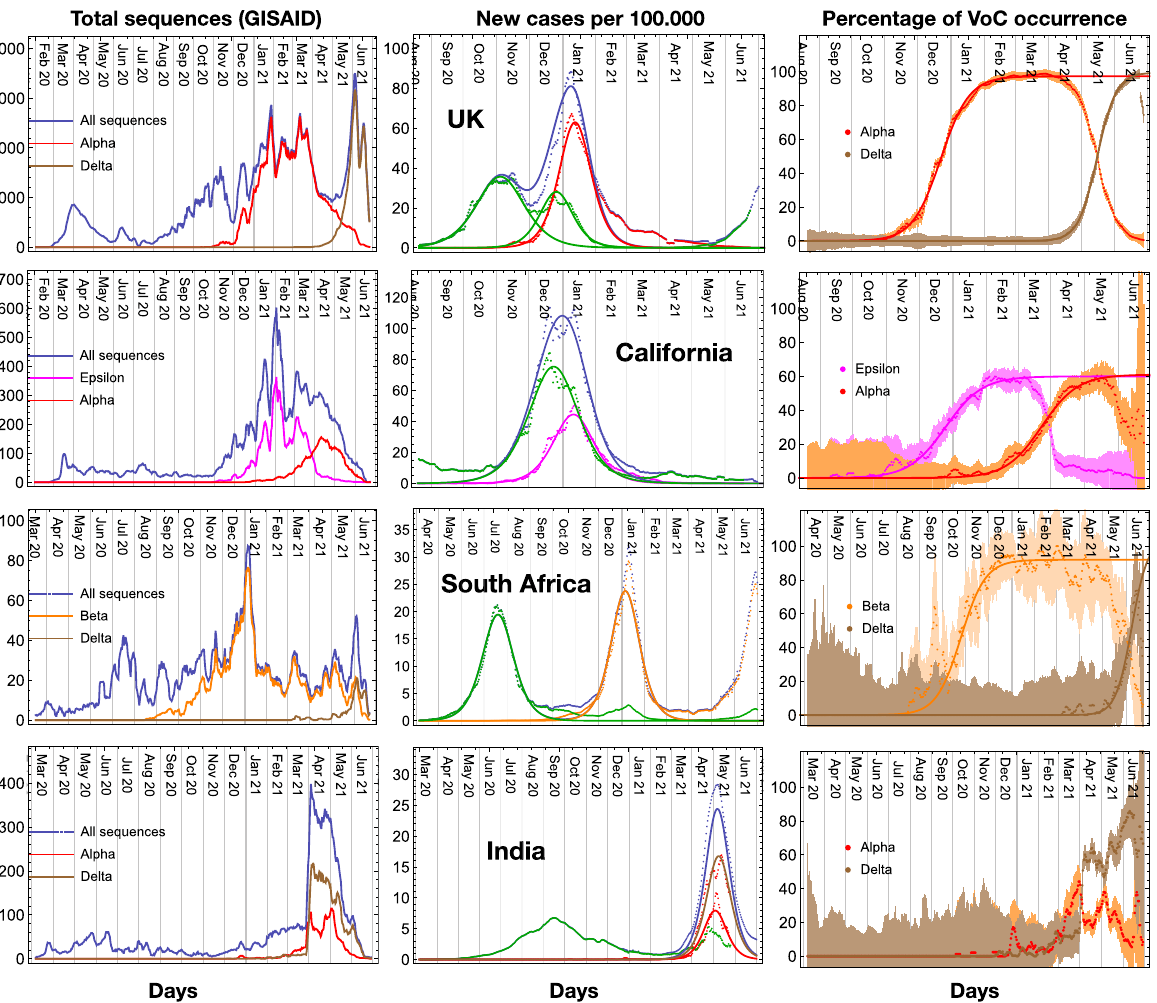
Figure 6. MeRG model for epidemiological data of variants. Results of the MeRG fitting of the number of infected associated to each relevant variant. Each row corresponds to a geographical region. In the left column we show the total number of sequencing available on GISAID (in colour the ones associated to the relevant VoC or VoI); the middle column shows the number of new daily infected (per 100.000 inhabitants); the right column shows the percentage of each VoC or VoI in the sequencing data. All plots show daily rates, with data smoothened over a period of 7 days. In the middle plots, the data are shown by dots, where blue corresponds to the total and the colours show the number of infected associated to each variant. The solid lines show the result of the fits to the MeRG model (note that only for the UK we fit the “standard variant”—in green-with two logistic functions). In the left plots, the error derives from the expected statistical variation on the number of daily sequences (after smoothening). For all the plots, the classification in variants derived from the GISAID